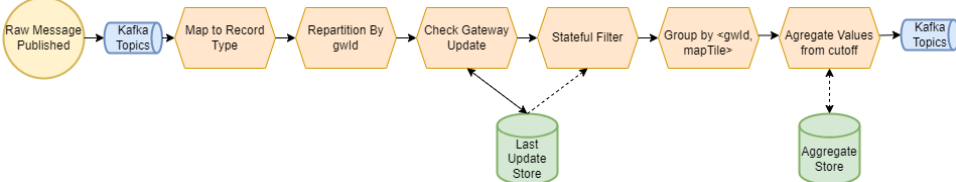
Figure 3. Sequence of steps performed by IoTMapperDataProcessing